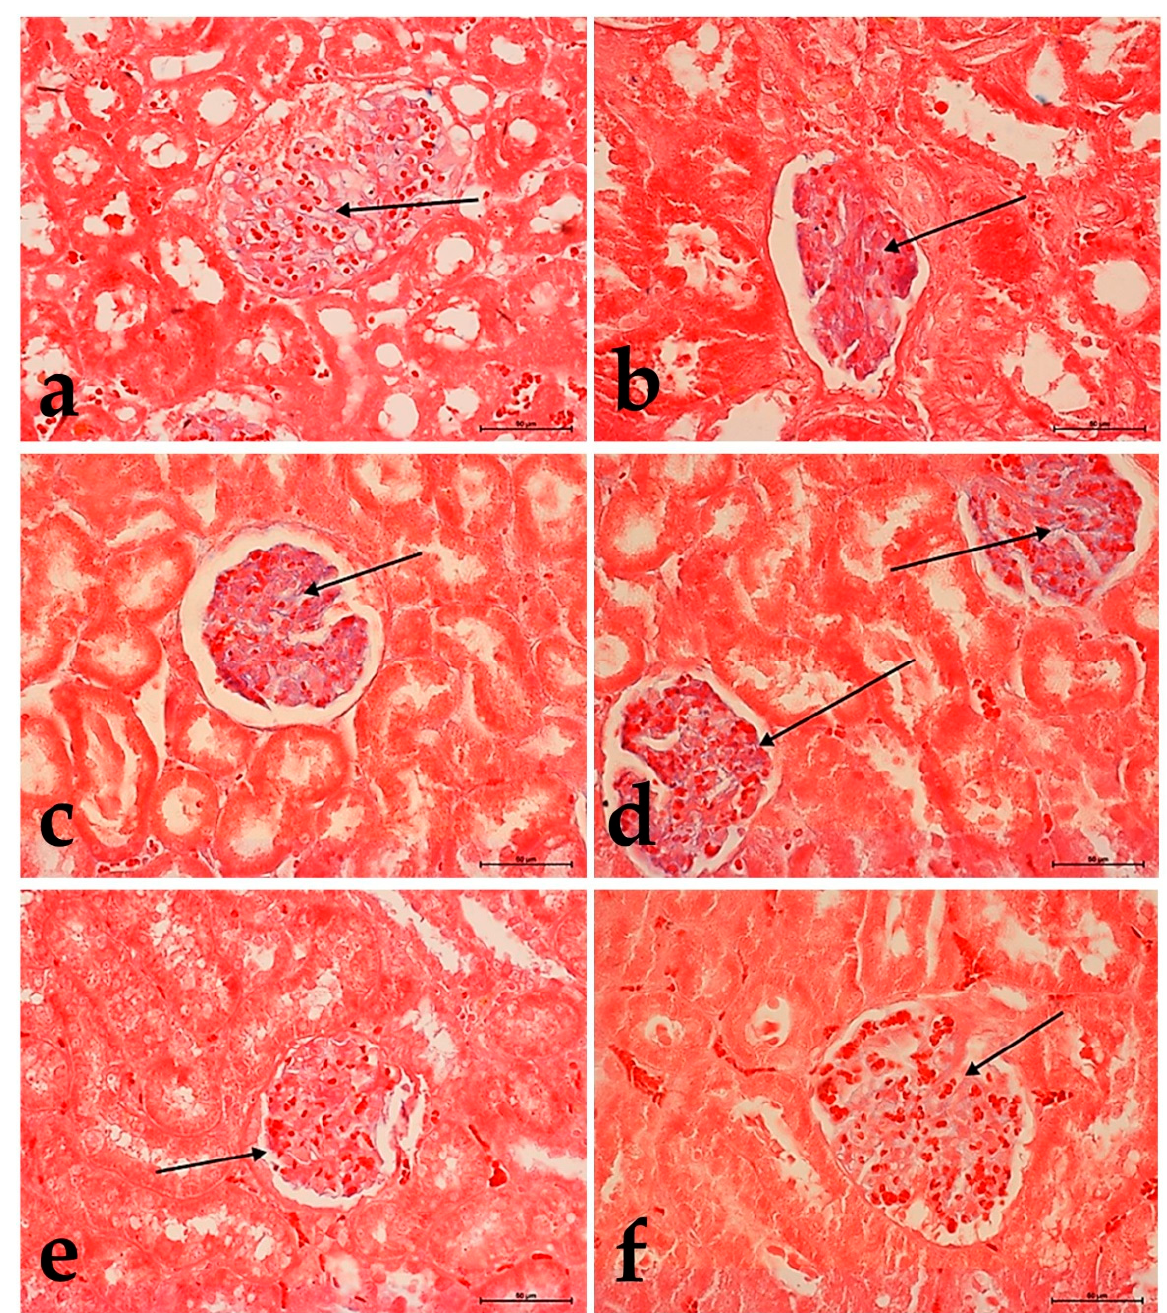
Figure 6. The changes in the proteoglycans content in the kidneys from groups IV ( a ), V ( c ), and VI ( e ) fed with normal diet and from groups IVa ( b ), Va ( d ), VIa ( f ) fed with a high-cholesterol diet. A glomerulus with different urine and blood content (black arrow). Noticeable differences in the lumen of proximal and distal tubules result from different levels of diuresis. Alcian blue staining. Mag. 400×, Bar scale 50 µm.